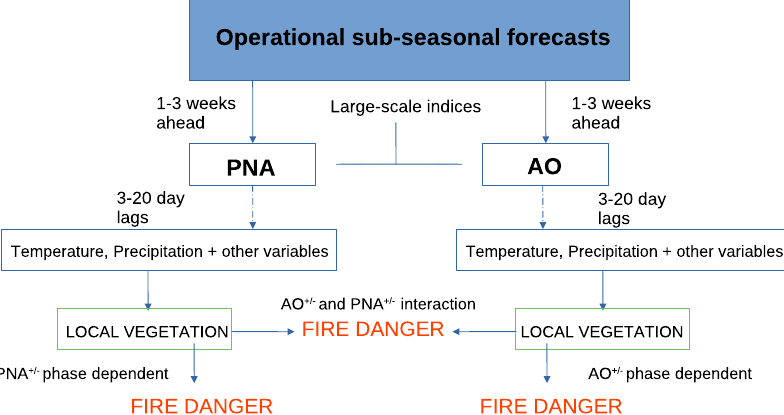
Fig. 8 Potential fi re danger forecast. Flowchart summarizing the practical applications of the AO and PNA forecasts to fi re danger management as a function of weather anomalies and local vegetation characteristics.